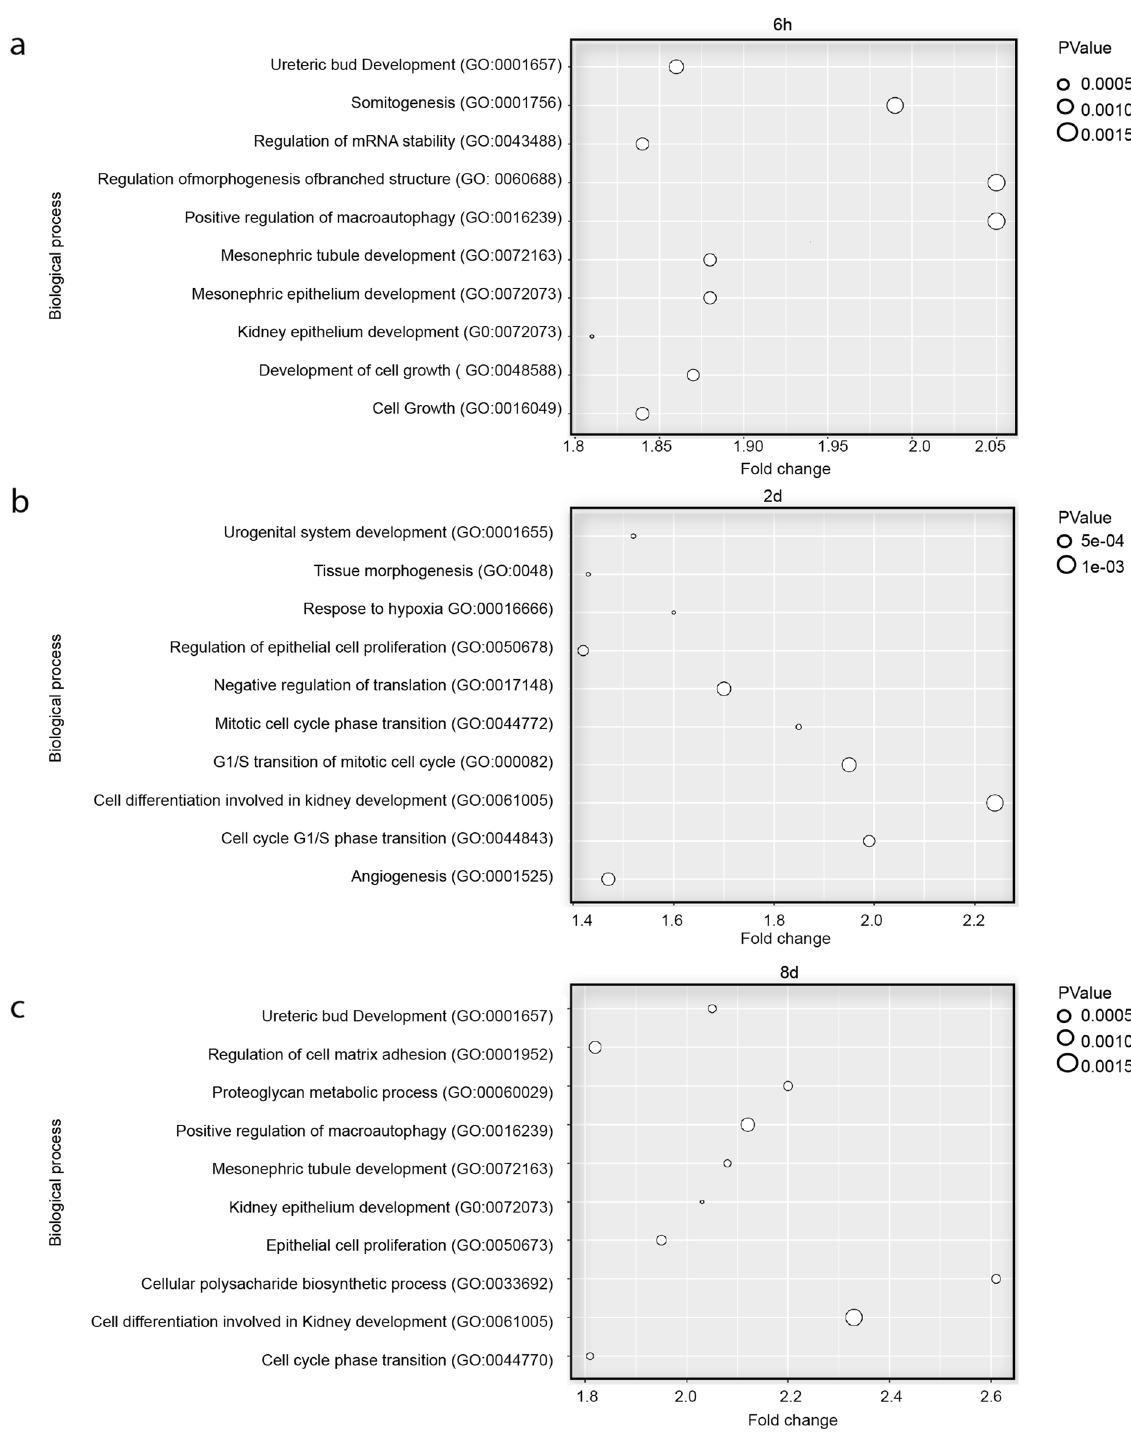
Figure 3. GO terms enrichment analysis. The graphs represent 10 different selected GO categories a). 6 h b). 2 days c). and 8 days post wounding. Both significance of the results and fold change are